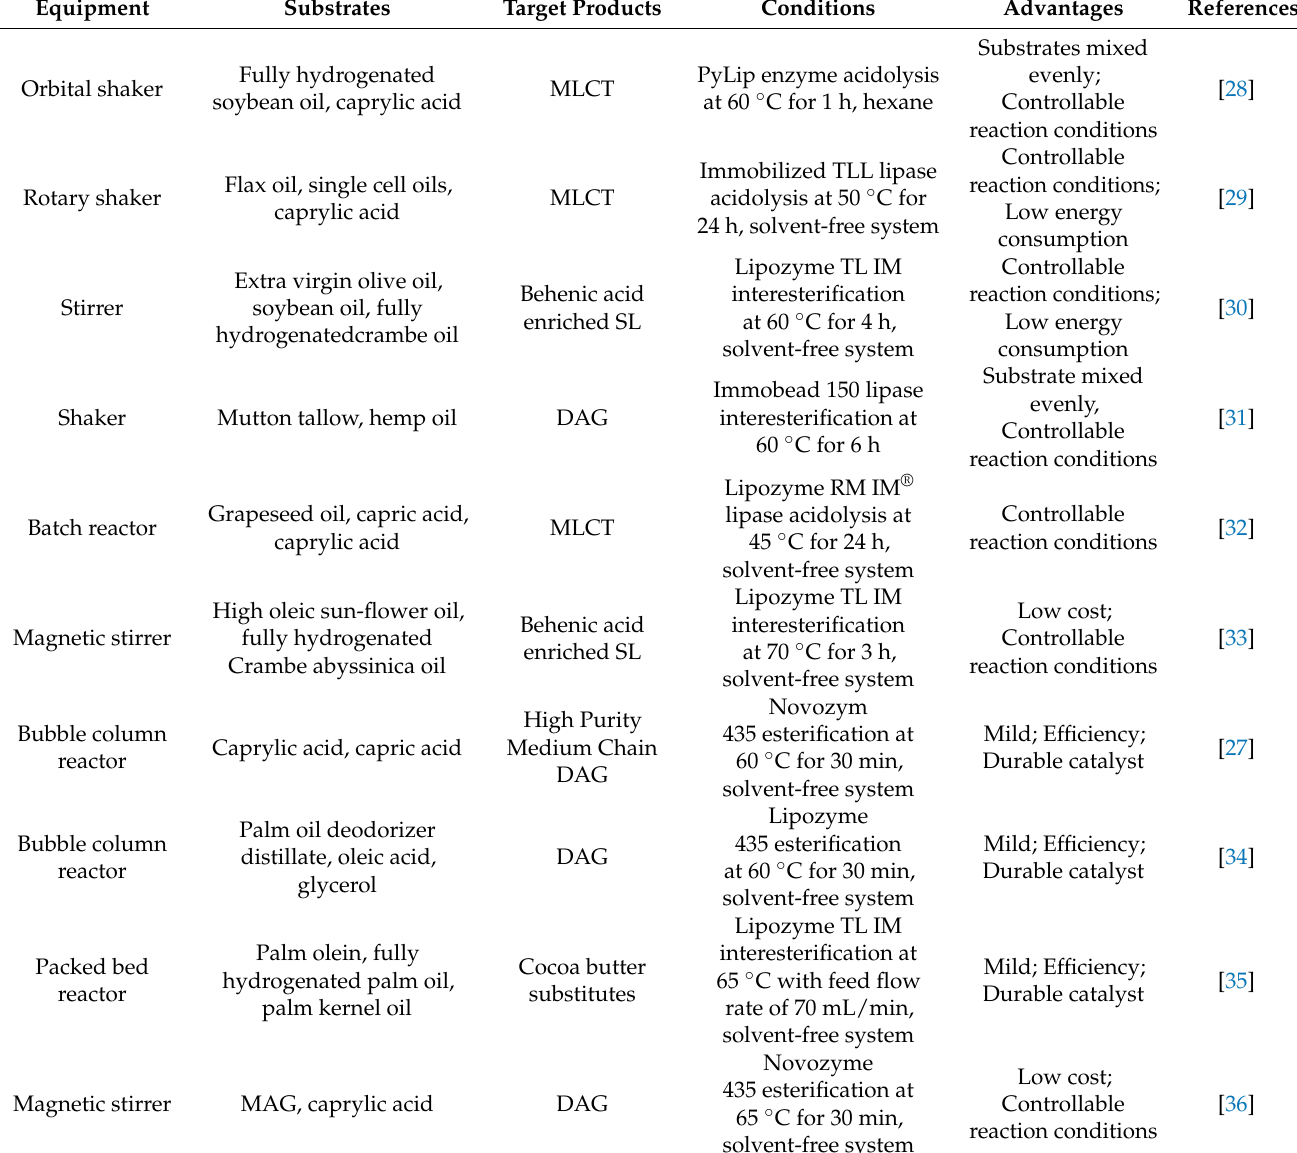
Table 2. Current enzyme reactors for SLs